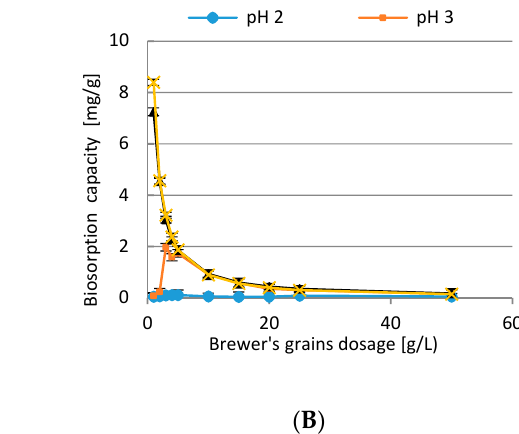
Figure 12. The impact of initial concentration of Cd(II) ions on BG residues removal efficiency. 3.4.3. Analysis of pH Profile